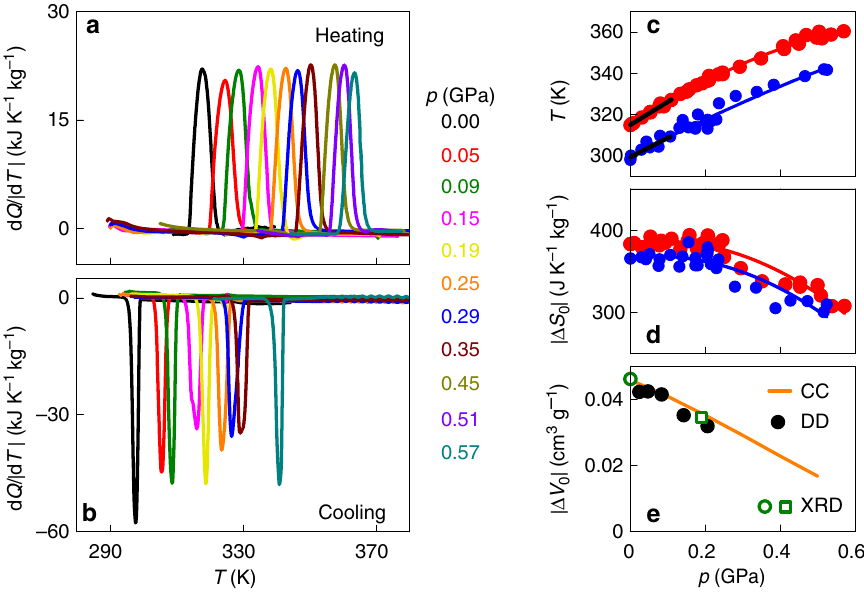
Fig. 2 Pressure-driven phase transition in NPG. a , b Measurements of d Q /|d T | on heating and cooling across the fi rst-order PC-OC transition for different values of increasing pressure p , after baseline subtraction. c , d Transition temperature and entropy change | Δ S 0 ( p )| on heating (red symbols) and cooling (blue symbols), derived from the calorimetric data of a , b and equivalent data at other pressures (shown in Supplementary Fig. 2). Black lines in c are linear fi ts. Red and blue lines in c , d are guides to the eye. e Volume change for the transition | Δ V p )|: solid symbols obtained from the dilatometric data (DD) in 0 ( Supplementary Fig. 3a; open circle obtained from the x-ray diffraction data in Fig. 1c, open square obtained from the x-ray diffraction data in Supplementary Fig. 3b; orange line obtained from c , d via the Clausius – Clapeyron (CC) equation